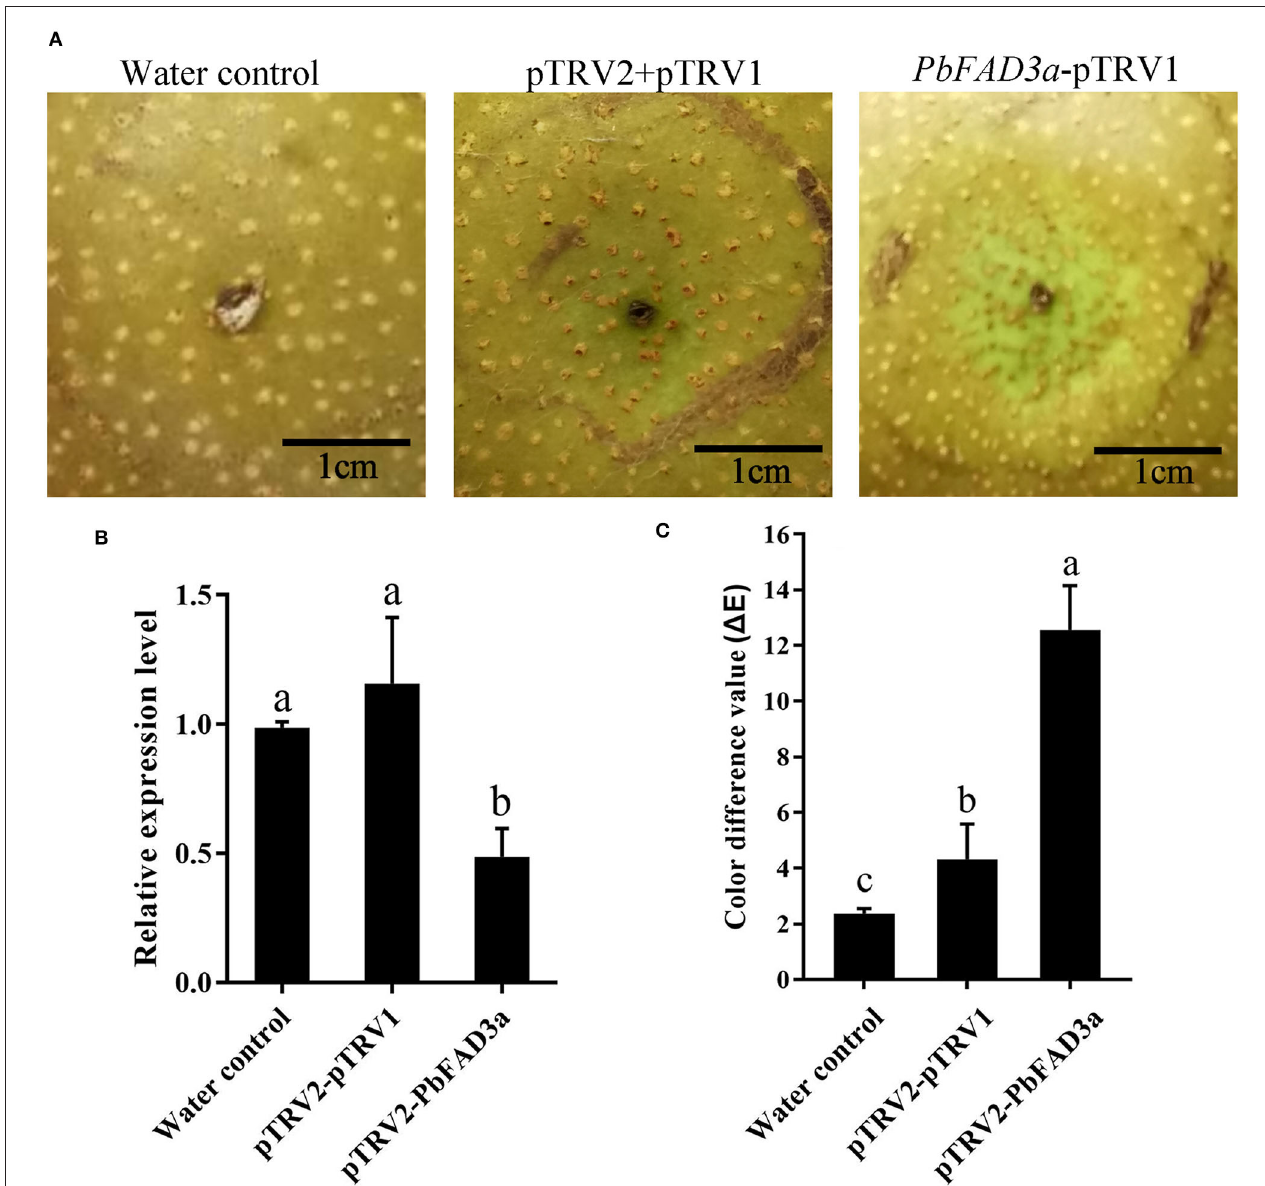
FIGURE 9 | The positive regulation of PbFAD3a in russet pear skin formation. (A) Virus-induced gene silencing (VIGS) of PbFAD3a in ‘Xiangnan’ pear peel at 35DAFB. (B) Relative expression level of PbFAD3a after 14 days after infiltration. (C) Color difference of pear exocarp after silencing of PbFAD3a . Phenotype was observed 14 days after infiltration. The error bars are the means ± SD of three biological repeats and lowercase letters indicate significant differences by two-tailed Student’s t -test ( p < 0.01).